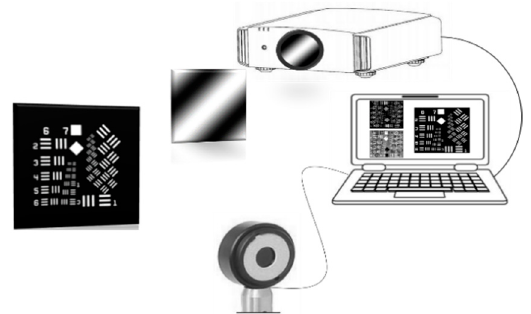
Figure 5. Schematic of the experimental set-up.